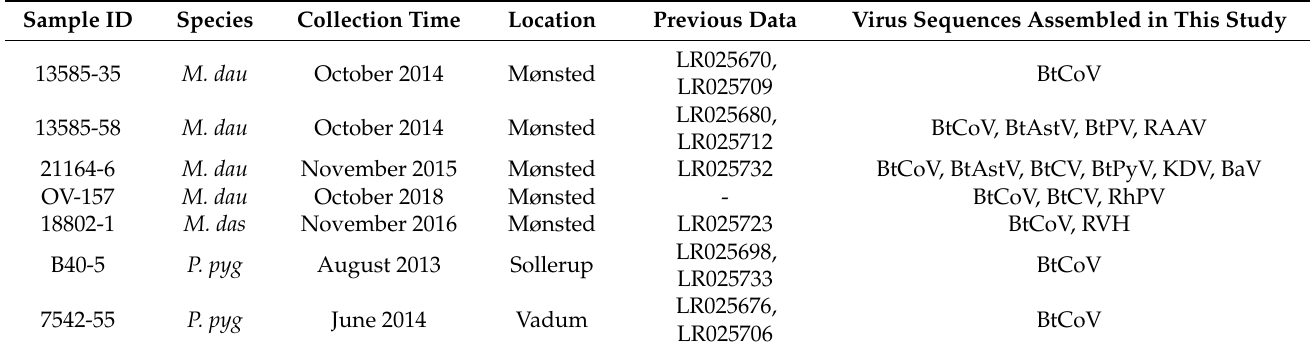
Table 1. Overview of bat faecal sample material used in the study. Previously published data mentioned with GenBank accession numbers consist of partial bat coronavirus ORF1b sequences of 208 or 130 nucleotides in